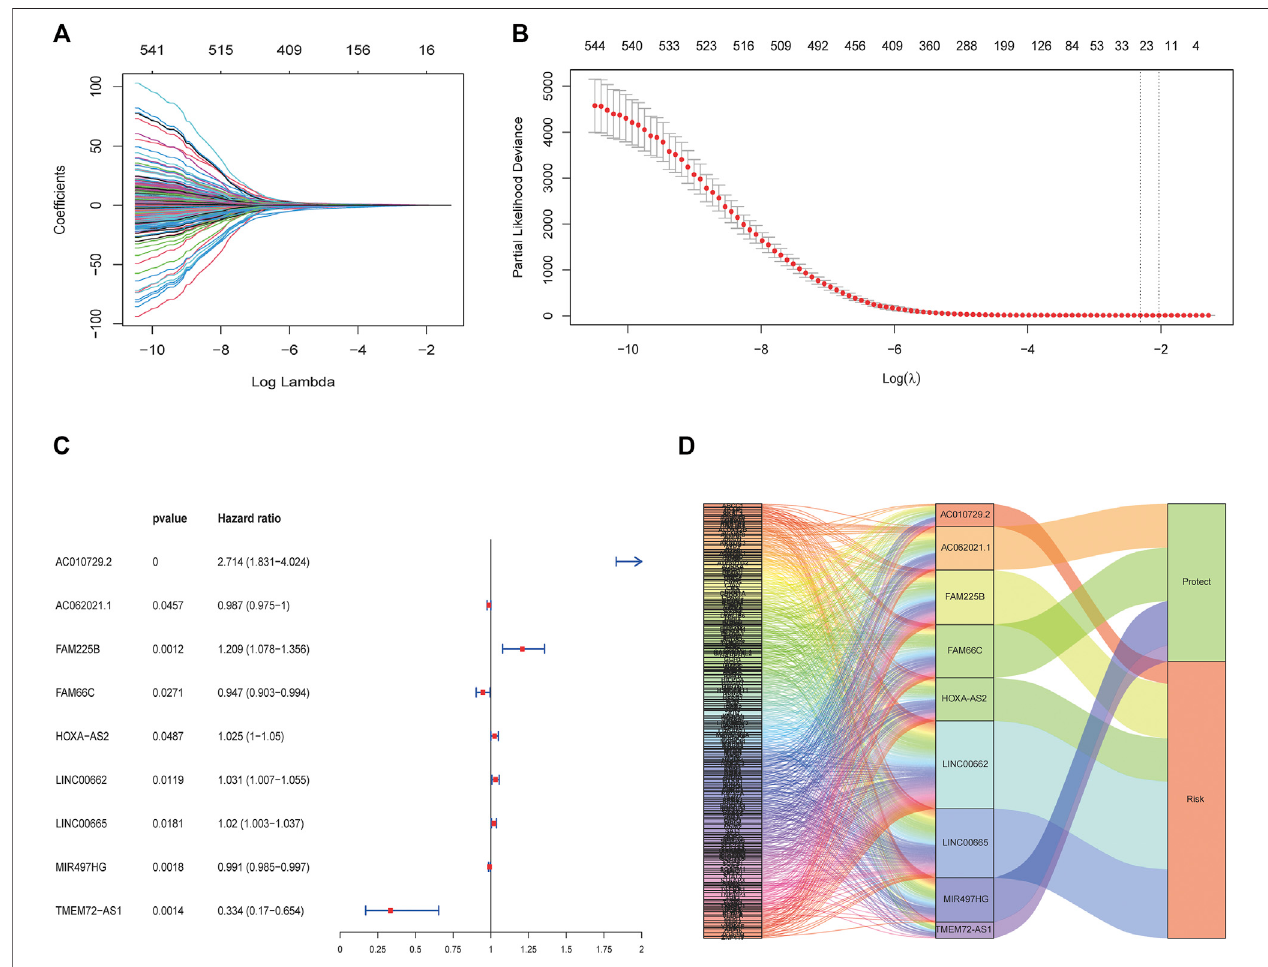
FIGURE 2 | Construction of the ferroptosis-related lncRNA prognostic biomarkers. (A, B) LASSO regression model. The red dots indicate the partial likelihood of deviancevalues,thegreylinesindicatethestandarderror(SE),andthetwoverticaldashedlinesontheleftandrightindicateoptimalvaluesbyminimumcriteriaand1-SE criteria, respectively. (C) Multivariate Cox regression analysis revealed that 9 ferroptosis-related lncRNAs were independent prognostic factors for glioma patients. (D) Sankey diagram shows the relationship among ferroptosis-related genes, ferroptosis-related lncRNAs, and risk types.